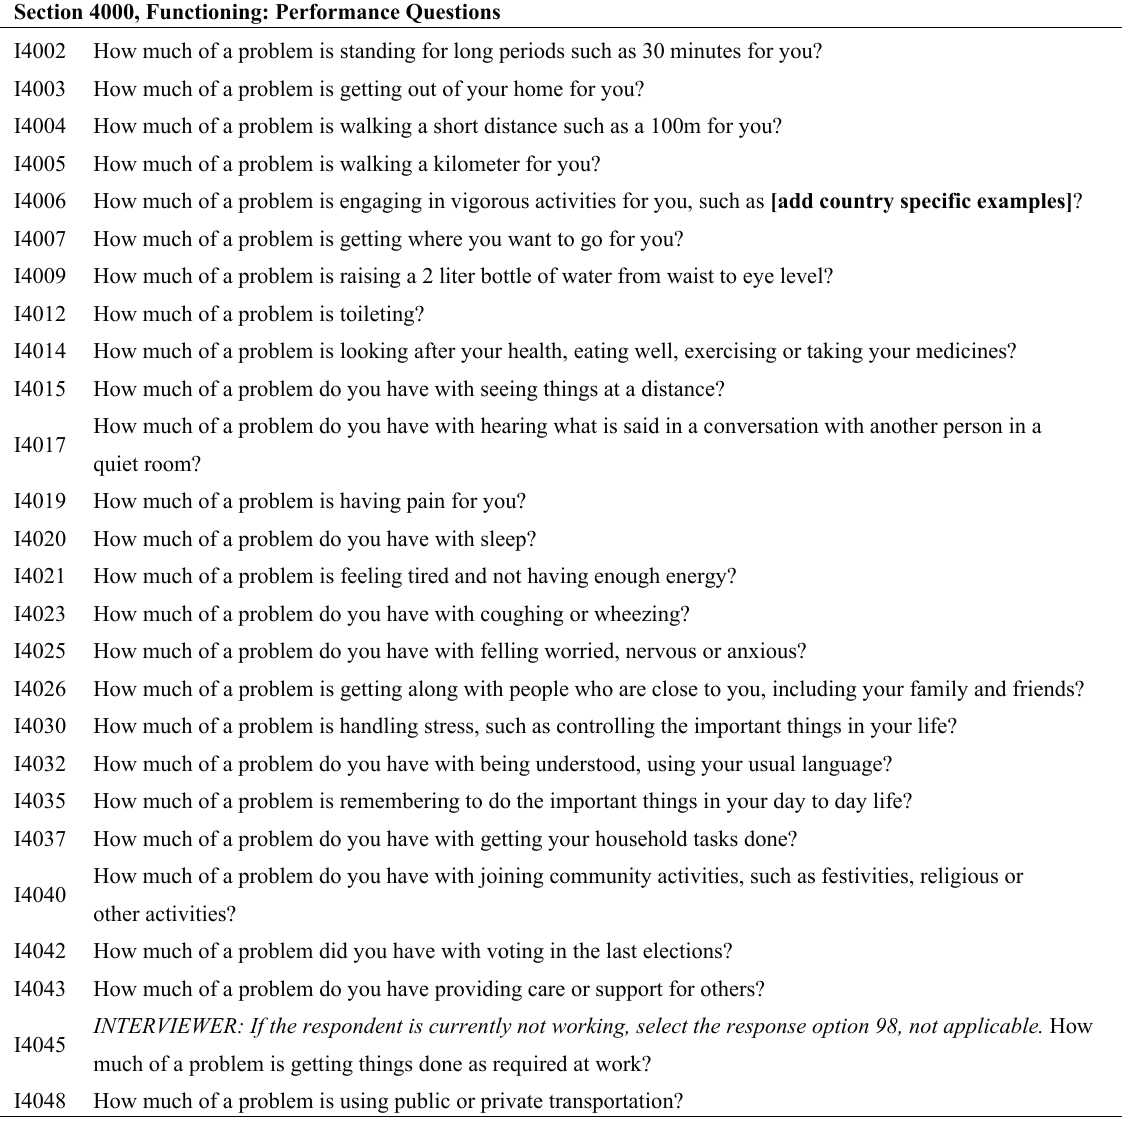
Table 1. Items of the Model Disability Survey, Alpha version, used to build the performance and capacity metric